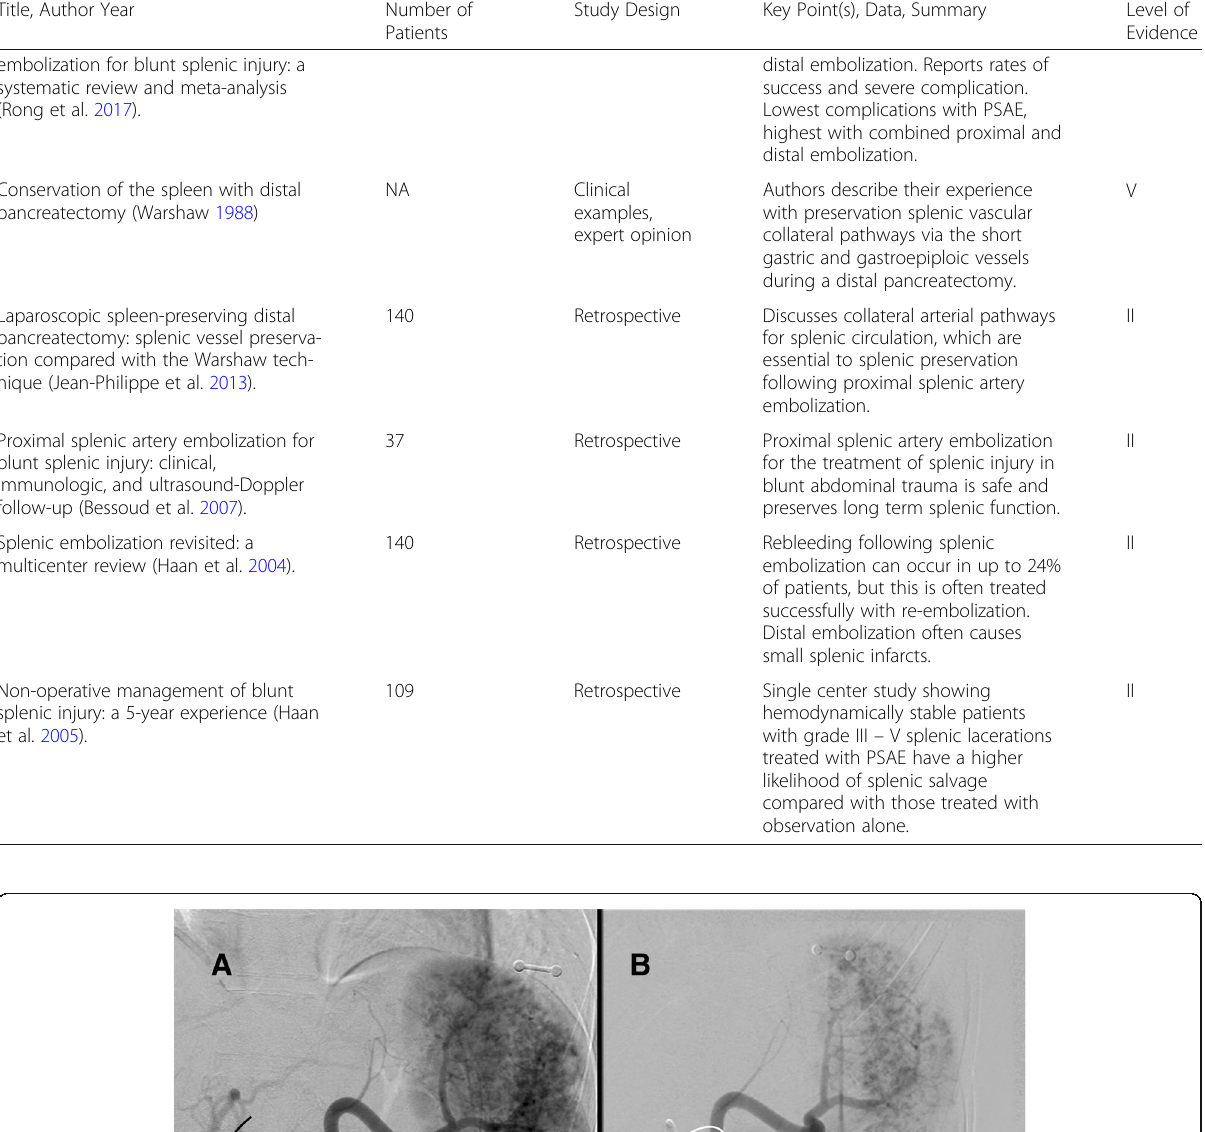
Table 2 Summary table of key studies on splenic embolization with a level of evidence designation. Levels of evidence are defined using the grading system adapted from the American Society of Plastic Surgeons and Johns Hopkins nursing evidence-based practice: Models and Guidelines (Burns et al. 2011; Dang and Dearholt 2017) - (see Table 5) (Continued)